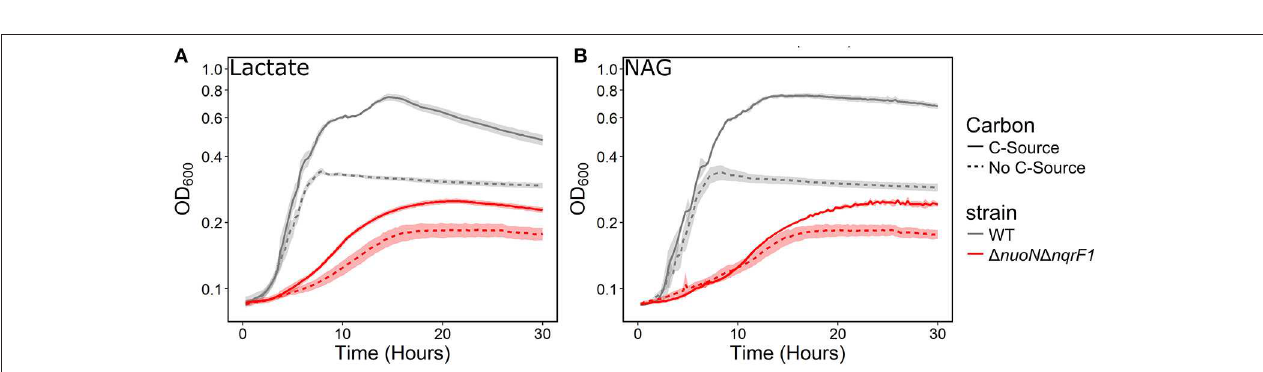
FIGURE 2 | Growth of WT (gray) and 1 nuoN 1 nqrF1 (red) in M5 minimal medium supplemented with 0.1% tryptone, with (solid line) or without (dashed line) (A) 20mM DL- lactate or (B) 10mM NAG as a carbon source. Growth in 1mL medium in 24-well plates at 30 ◦ C with